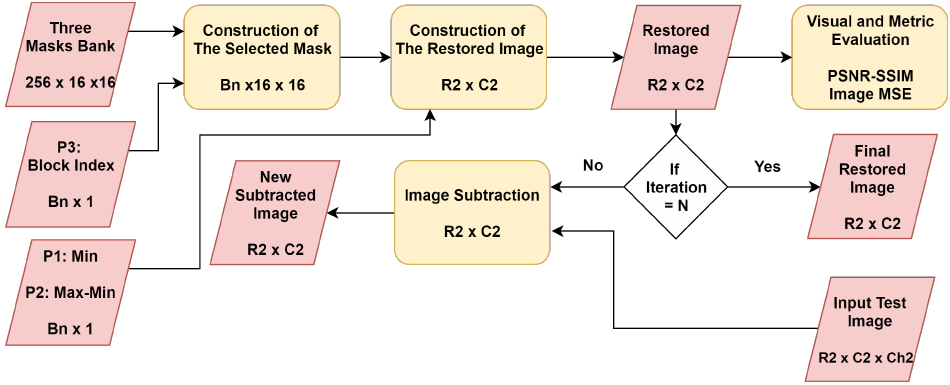
Figure 8. The image restoration